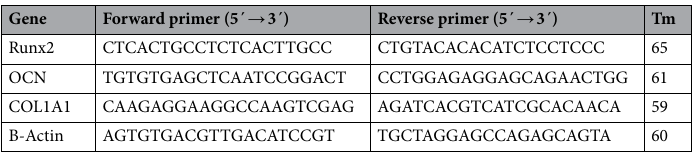
Table 1. Sequences and melting temperature of